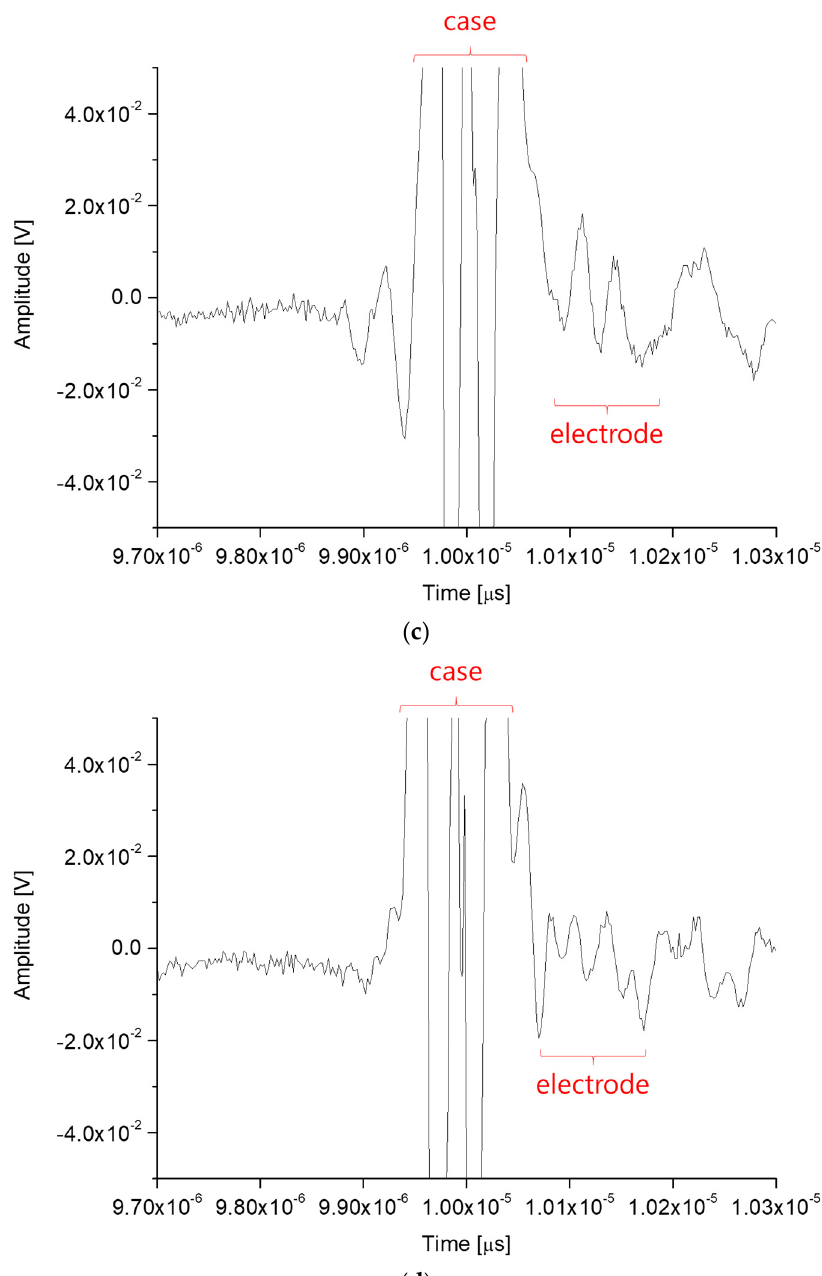
Figure 5. Ultrasonic signals obtained by reflection from a lithium-ion battery with different weld status: ( a ) non-welding, ( b ) insufficient welding, ( c ) good welding, and ( d ) excessive welding.